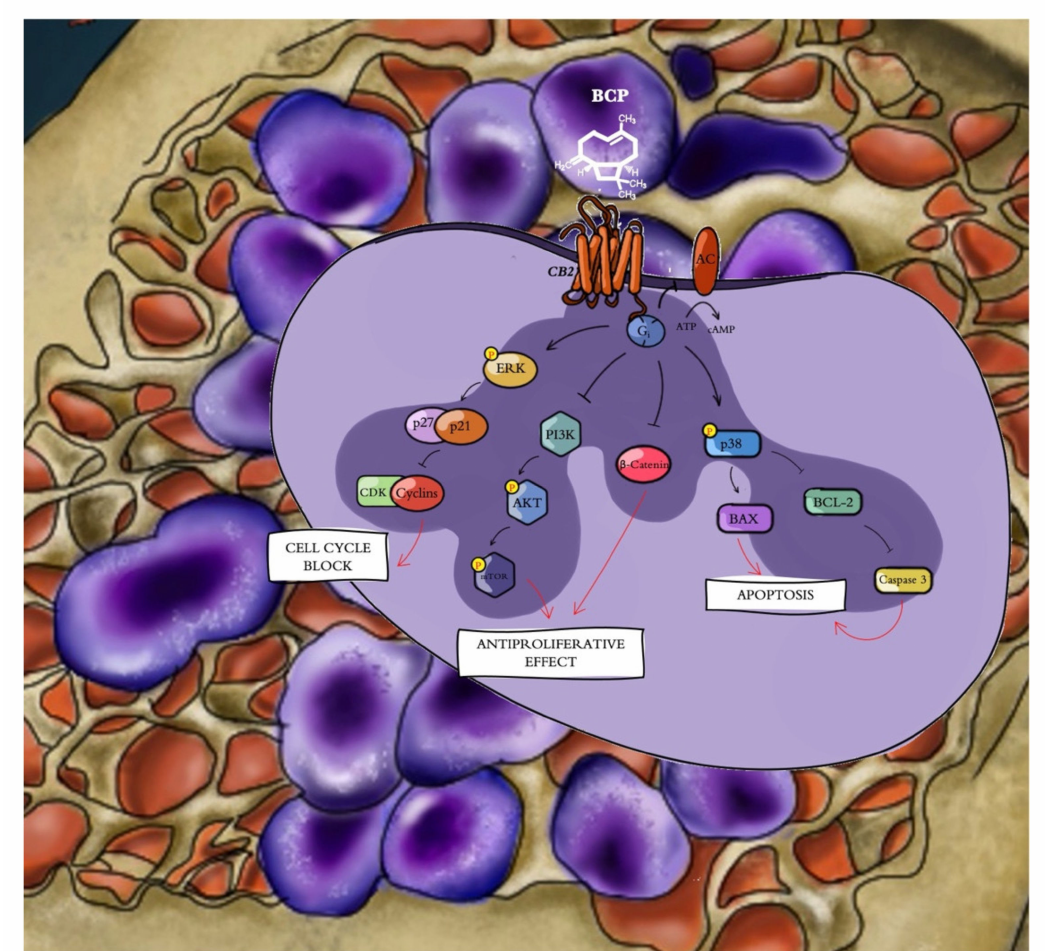
Figure 8. Beta-caryophyllene ( β -caryophyllene, BCP) selectively binds cannabinoid type 2 receptor (CB2R), thus inducing an antiproliferative effect through (i) cell cycle modulation by reducing cyclin D1 and Cdk 4/6 expression, (ii) apoptosis activation by increasing Bax and caspase 3 and reducing Bcl-2 expression, and (iii) Akt and β -catenin